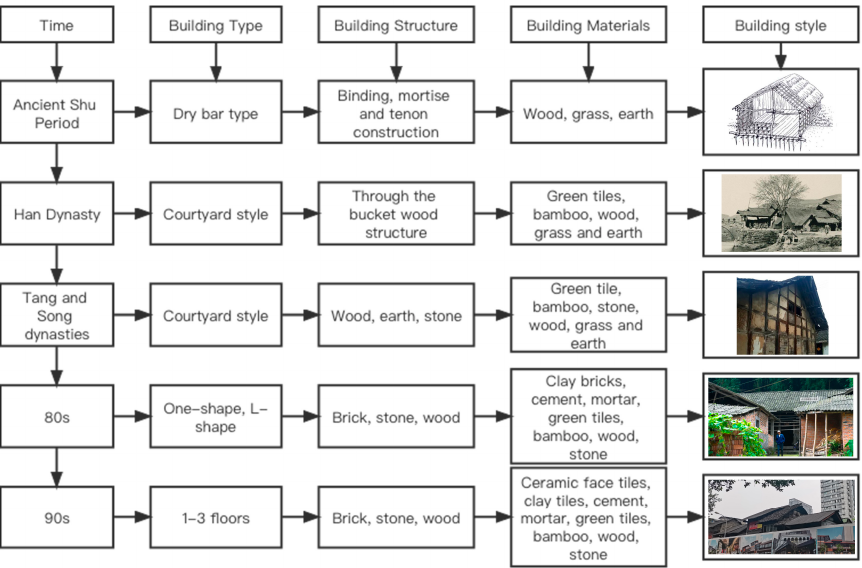
Figure 9. Construction Method of Farmhouse Forest in Western Sichuan Province.